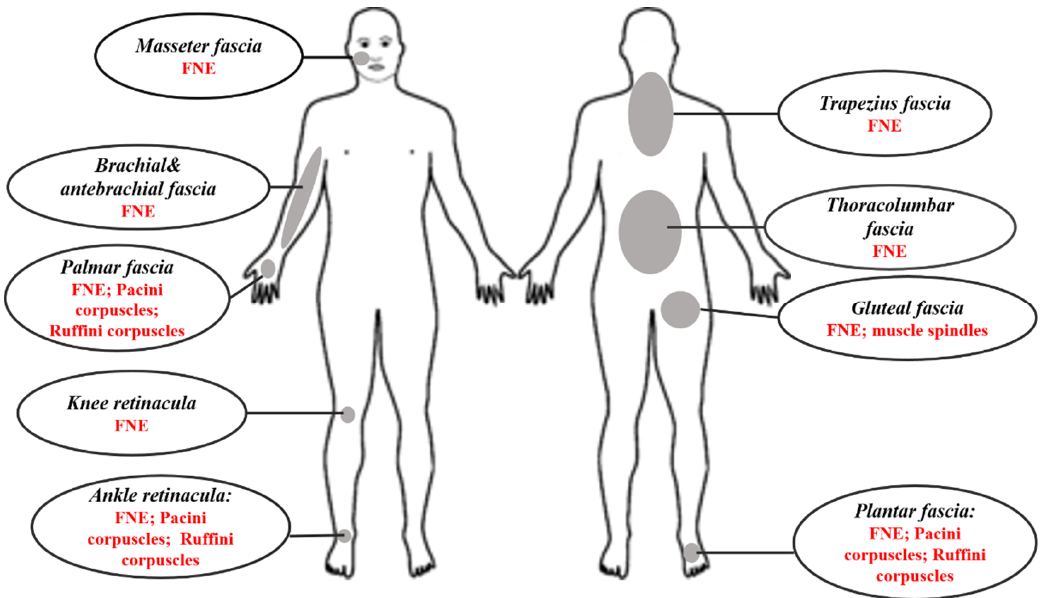
Figure 2. Graphical representation of the described sites and types of innervation.